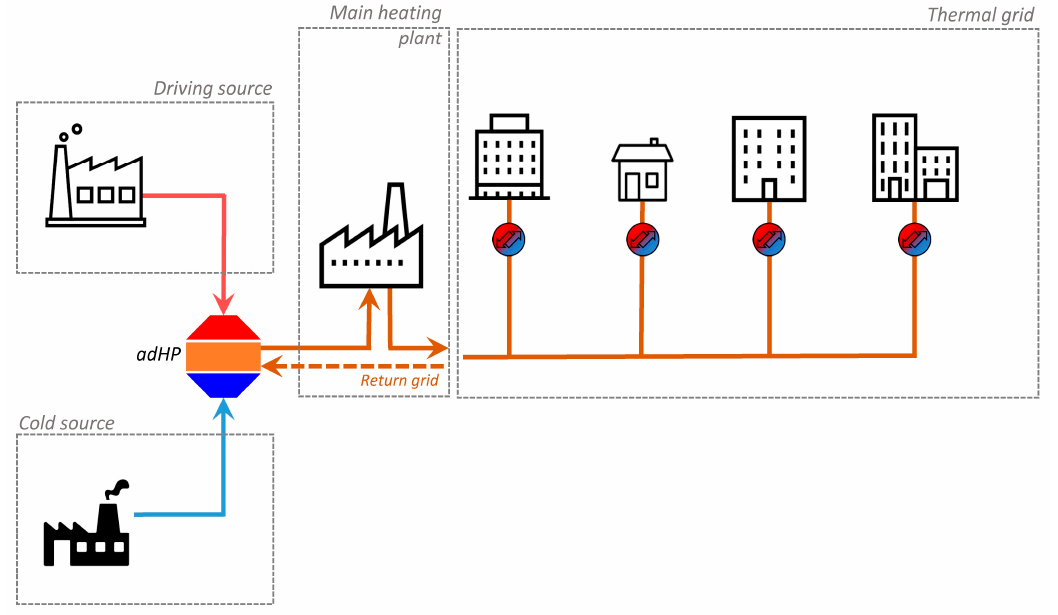
Figure 4. Schematic representation of Scenario 1.